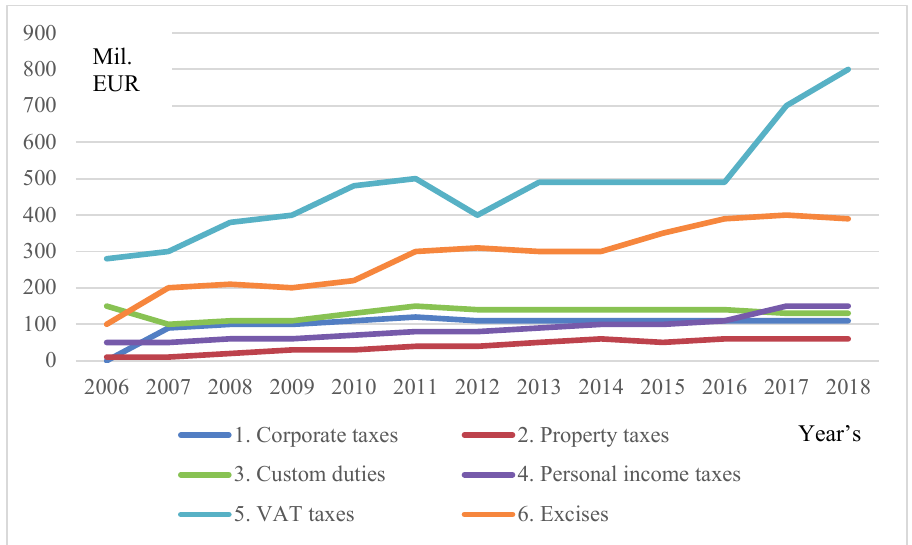
Fig. 1. Categories of public revenues in the Republic of Kosovo in 2006–2018, million euros (Budget of the Republic of Kosovo, Ministry of Finance (MoF), Annual Financial Report of